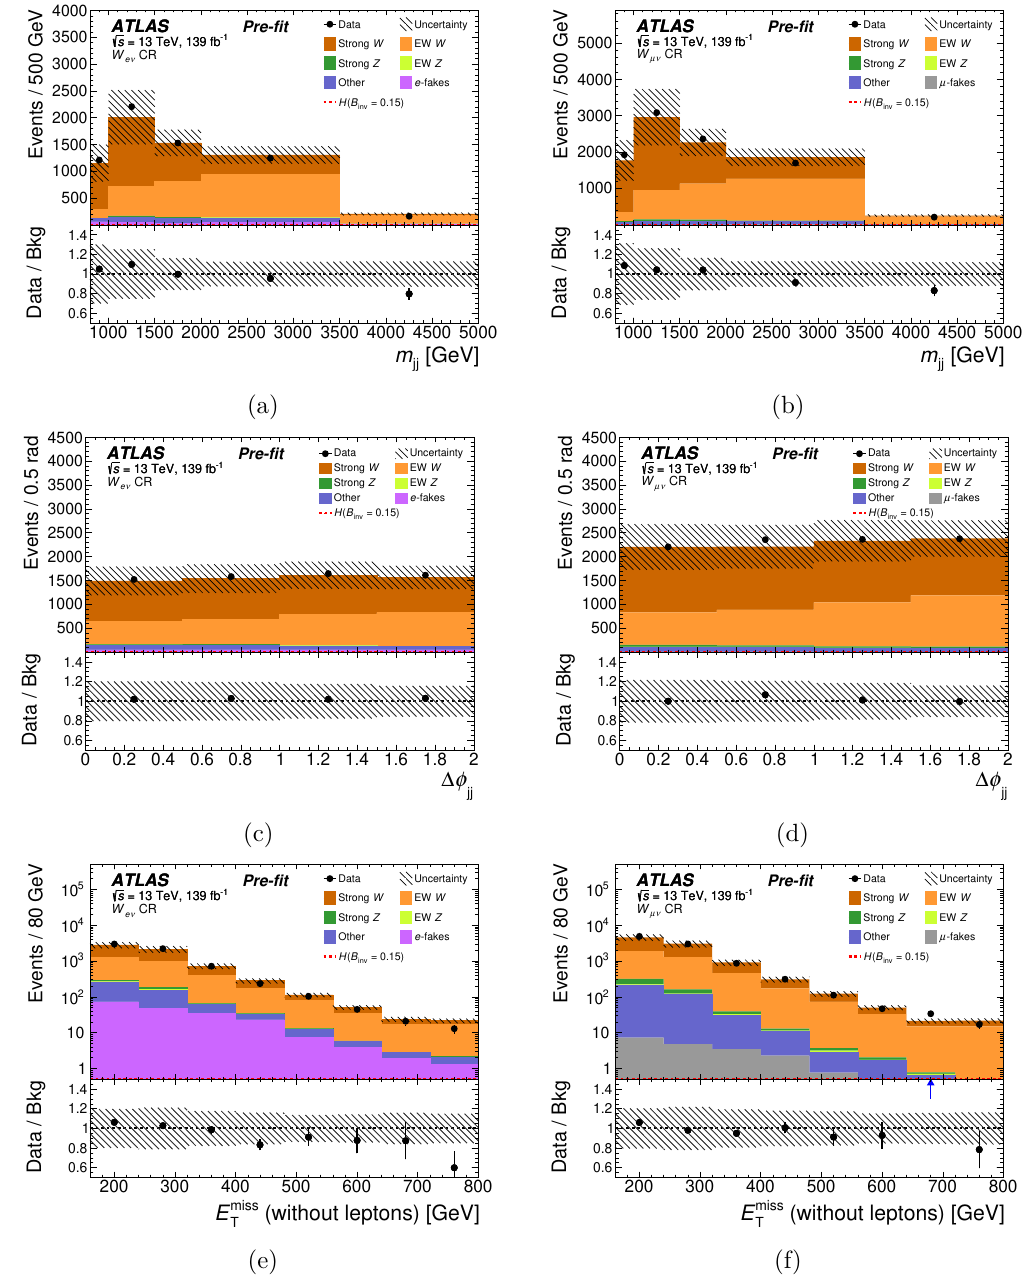
(without leptons) in Figure 5. Observed and predicted distributions of m jj , ∆ φ jj , and E miss T the W ((a), (c), and (e)) and W ((b), (d), and (f)) control regions. The MC predictions are eν µν normalised to cross sections times luminosity and are shown prior to the likelihood fit. The small contribution from fake electrons is the expected contribution after the combined likelihood fit. Minor contributions from t ¯ t , V V , V V V , and VBF H with H → τ + τ − or H → W ∗ W are combined and labelled ‘other’. The hatched band indicates statistical and experimental systematic